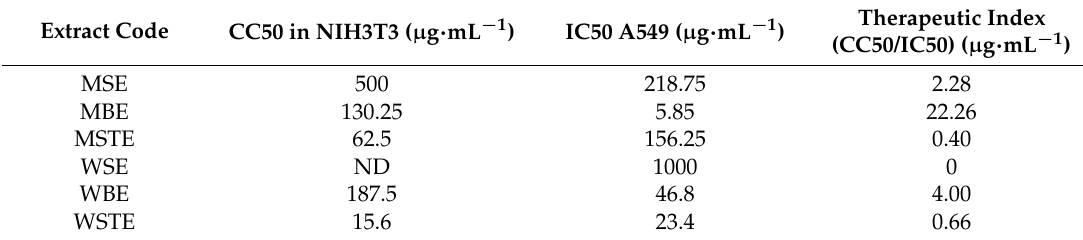
Figure 2. Cytotoxicity of different methanolic and water extracts of T. vernicifluum . Methanolic seed extract (MSE), methanolic bark extract (MBE), methanolic seed extract (MSTE), water seed extract (WSE), water bark extract (WBE), water stem extract (WSTE). Data are mean ± standard error (SEM, n = 3). * p < 0.05 is significantly non-cytotoxic to A549 cells than other types of extracts. ∆ p < 0.05 is significantly cytotoxic to A549 cells than other types of extracts. Table 2. Evaluation of the therapeutic index of various extracts derived from T. vernicifluum . MeOH seed extract (MSE), MeOH bark extract (MBE), MeOH seed extract (MSTE), water seed extract (WSE), water bark extract (WBE), water stem extract (WSTE). ND- Not